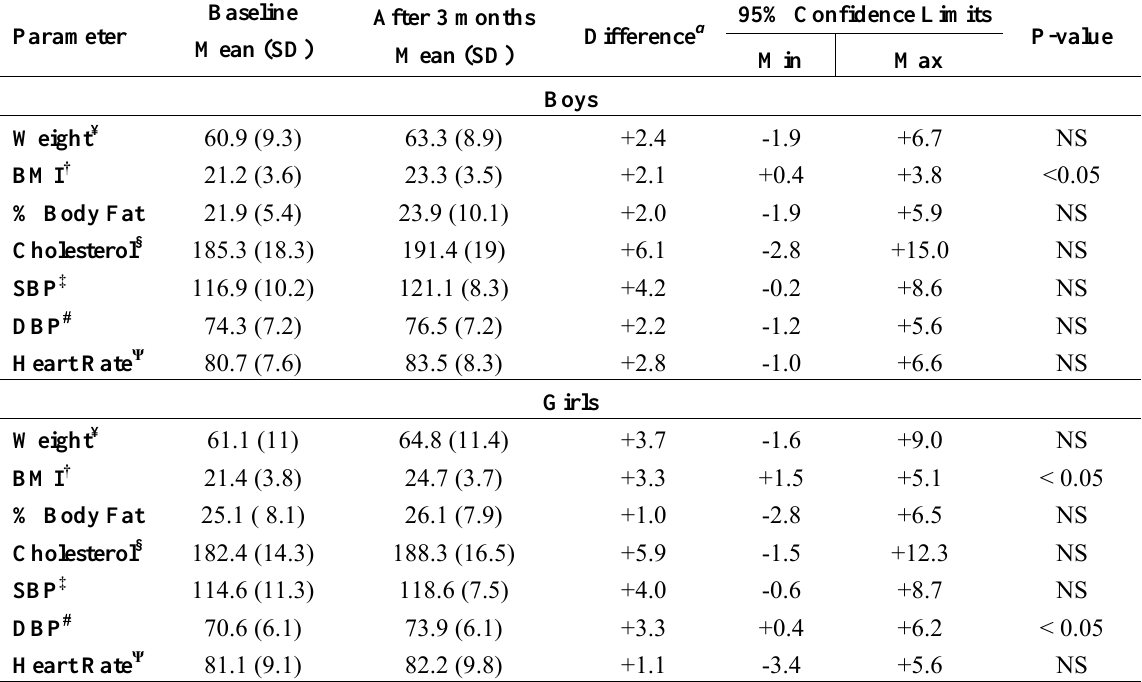
Table 3. Anthropometric and physiological parameters at baseline and 3 months later of control pupils by